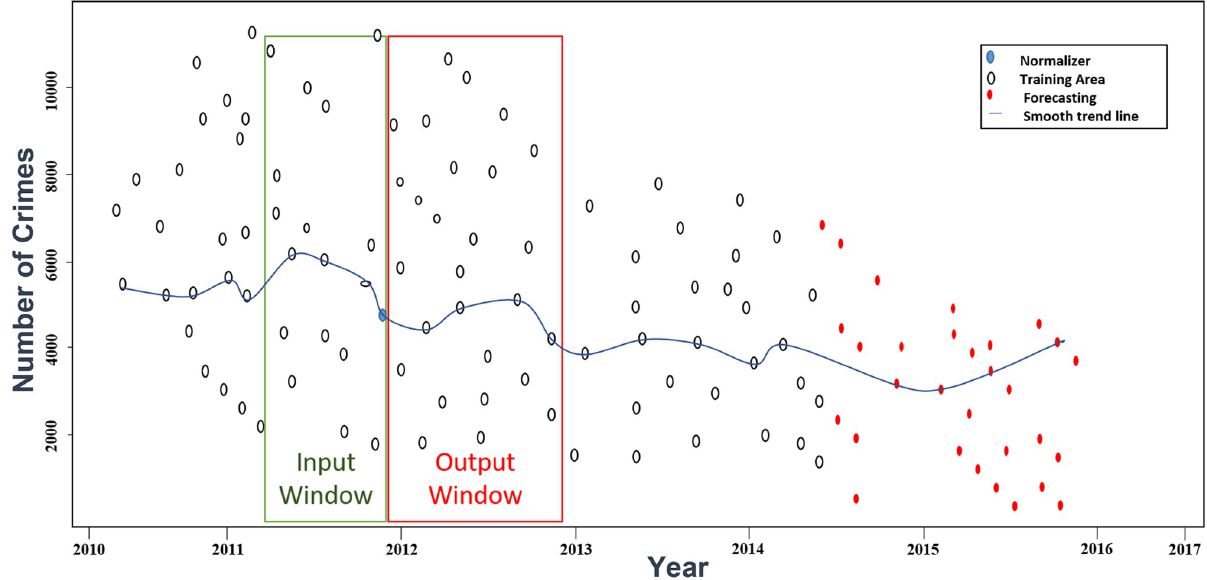
Fig 5. Sliding window strategy for selecting the best